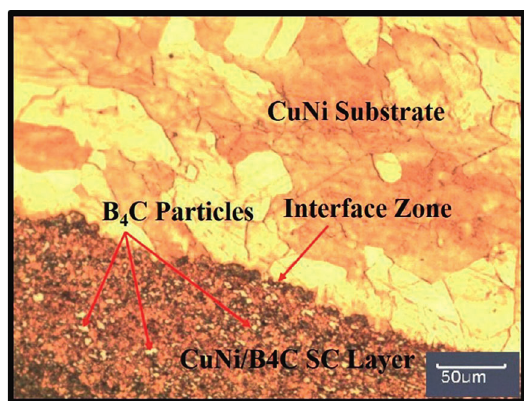
Figure 10: XRD analysis of FSP sample indicating the dominating peaks of reinforced carbide particle and base material.